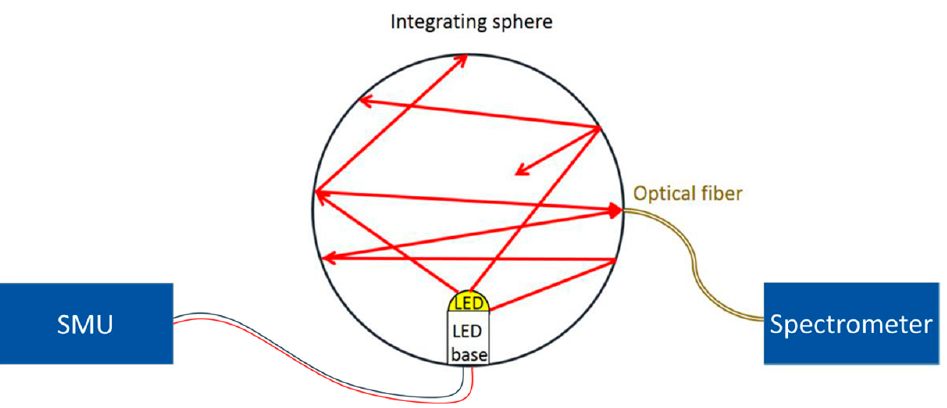
Figure 2. Integrating sphere setup (adapted from [17]). This configuration allows the intensity emitted by the sample to be measured, integrat- ing it over all directions. The system response is calibrated before the sample measurement with two halogen sources (Labsphere SCL-600 and AUX-600 [24]) to obtain the spectral intensity, expressed in W per nm. The inclusion of an SMU allowed the LEDs to be driven at specific currents while monitoring the necessary voltage in real time. Each color of each sample has been characterized using a stepped process over sev- enteen injected current values ranging between 0.5 mA and 1 A. At each current value, the LED was kept ON for one minute and then turned OFF for another minute before the next step, to reduce the effects of self-heating. The temperature outside of the sphere was monitored during the test. It remained between 22 ◦ C and 25 ◦